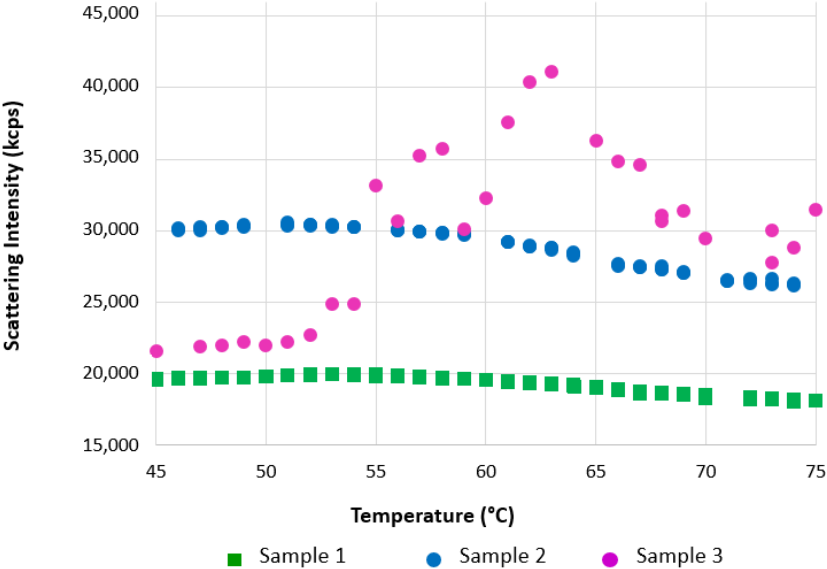
Figure 8. Thermal ramps of full rAAV5 capsids using different buffer and experimental condi- Sample 1 = PBS at 1 ◦ C/min; Sample 2 = PBS at 3 ◦ C/min; Sample 3 = PBS plus 20 mM EDTA at tions. Sample 1 = PBS at 1 °C/min; Sample 2 = PBS at 3 °C/min; Sample 3 = PBS plus 20 mM EDTA 1 ◦ at 1 °C/min.